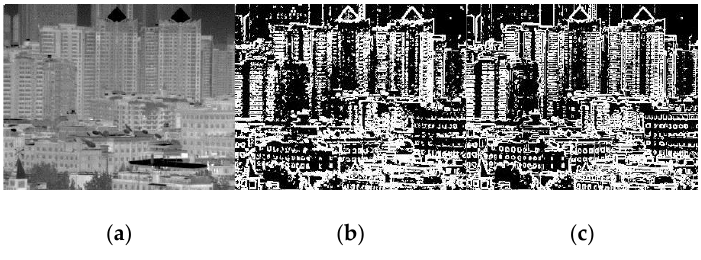
Figure 3. Comparison of image edge extraction: ( a ) original image; ( b ) spatial correlation by 3 × 3 window; and ( c ) Sobel operator.